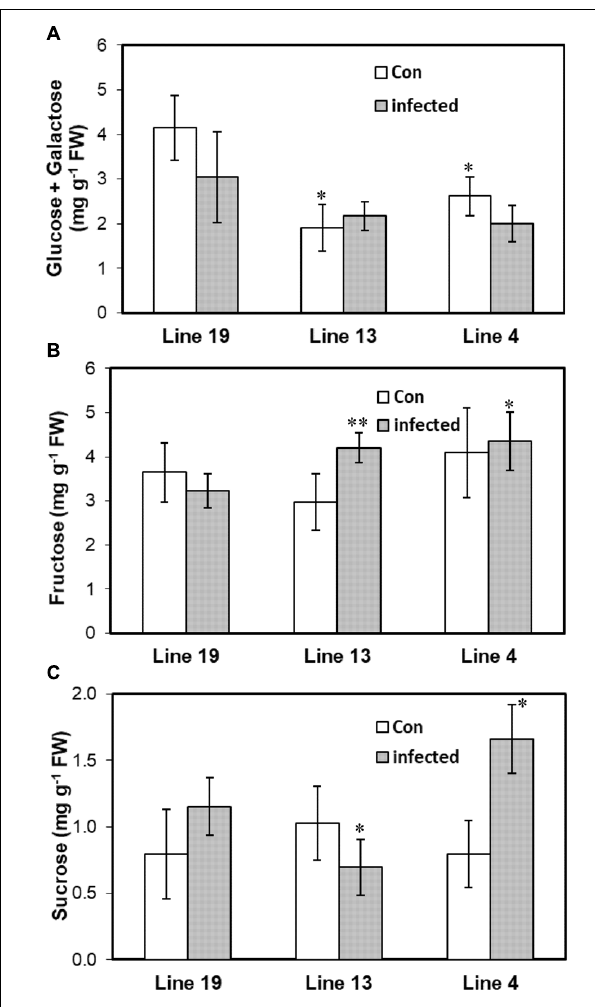
FIGURE 5 | Leaf carbohydrate contents vary in the BCTV susceptible (Line 19; S) vs. resistant (Line 13 and Line 4; R) sugar beet genotypes. Cellular content of (A) glucose + galactose, (B) fructose, and (C) sucrose at 6 dpi in the uninfected control (Con) and inoculated plants. Data are Mean ± SE